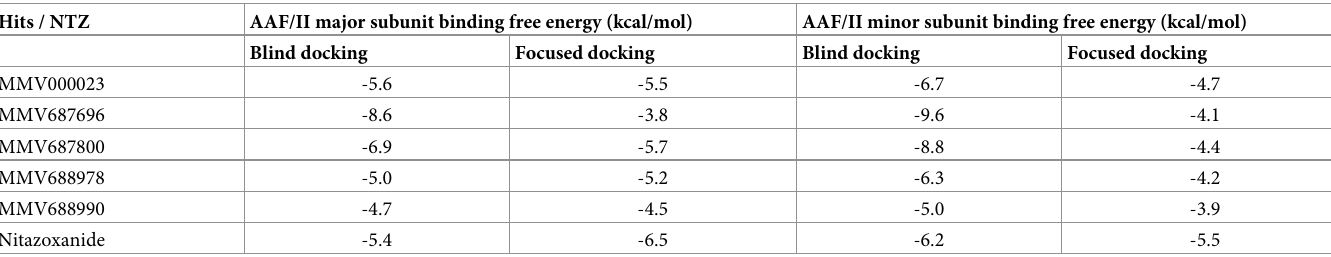
Table 3. Free energy of interaction between hit molecules and AAF/II major and minor subunits of EAEC strain 042. Hits /